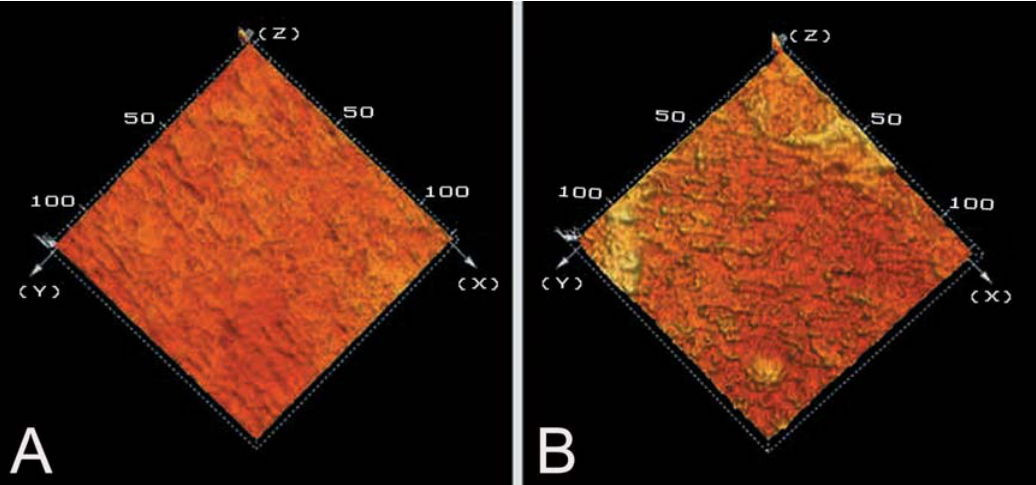
Figure 3- Confocal laser scanning microscopy topographical images. A: root surface treated with hand curettes showing (cid:13)(cid:4)(cid:11)(cid:2)"(cid:7)(cid:13)(cid:11)(cid:30)(cid:4)(cid:5)"(cid:8)(cid:13)(cid:9)(cid:4)(cid:14)(cid:13)$(cid:8)(cid:9)(cid:4)(cid:11)(cid:31)(cid:13)(cid:9)(cid:13)(cid:11)(cid:30)(cid:8)(cid:9)(cid:12)=(cid:8)(cid:25)(cid:4)#$(cid:4)(cid:30)(cid:31)(cid:8)(cid:4)(cid:7)(cid:9)(cid:8)(cid:5)(cid:8)(cid:24)(cid:11)(cid:8)(cid:4)(cid:2)(cid:3)(cid:4)(cid:5)(cid:6)(cid:7)(cid:8)(cid:9)(cid:10)(cid:11)(cid:12)(cid:13)(cid:14)(cid:4)(cid:3)(cid:6)(cid:9)(cid:9)(cid:2)(cid:15)(cid:5)/(cid:4)6(cid:2)(cid:4)(cid:8);(cid:7)(cid:2)(cid:5)(cid:8)(cid:25)(cid:4)(cid:25)(cid:8)(cid:24)(cid:30)(cid:12)(cid:24)(cid:4)(cid:30)(cid:6)#(cid:6)(cid:14)(cid:8)(cid:5)(cid:4)(cid:15)(cid:8)(cid:9)(cid:8)(cid:4)(cid:2)#(cid:5)(cid:8)(cid:9)%(cid:8)(cid:25)(cid:4) subsequent to the mechanical periodontal treatment with the curettes; B: root surfaces treated using the piezoelectric scaler, showing an irregular and coarse root surface with few shallow grooves pits and tips